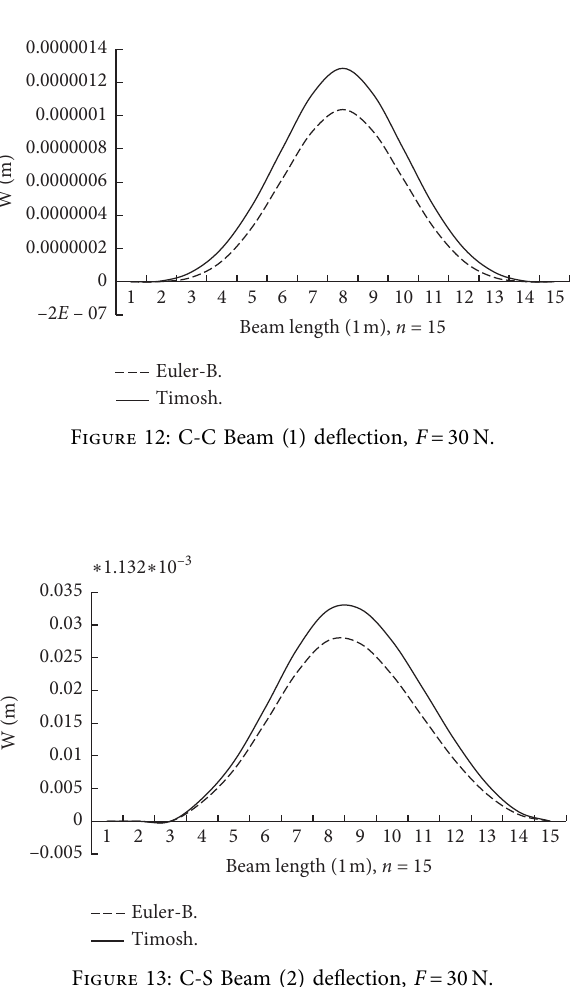
Figure 13: C-S Beam (2) deflection, F � 30 N.